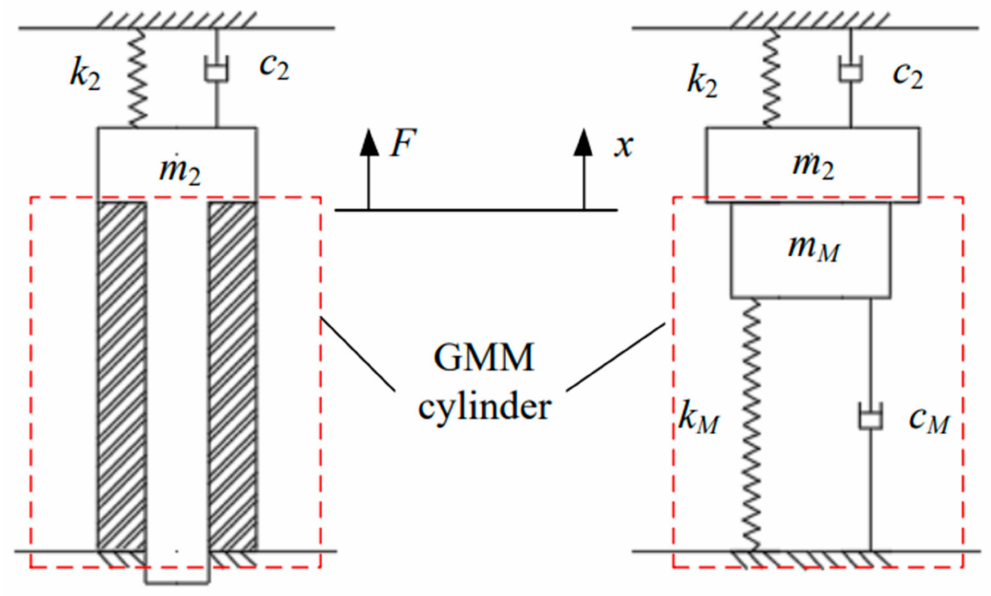
Figure 4. GMA single-degree-of-freedom displacement